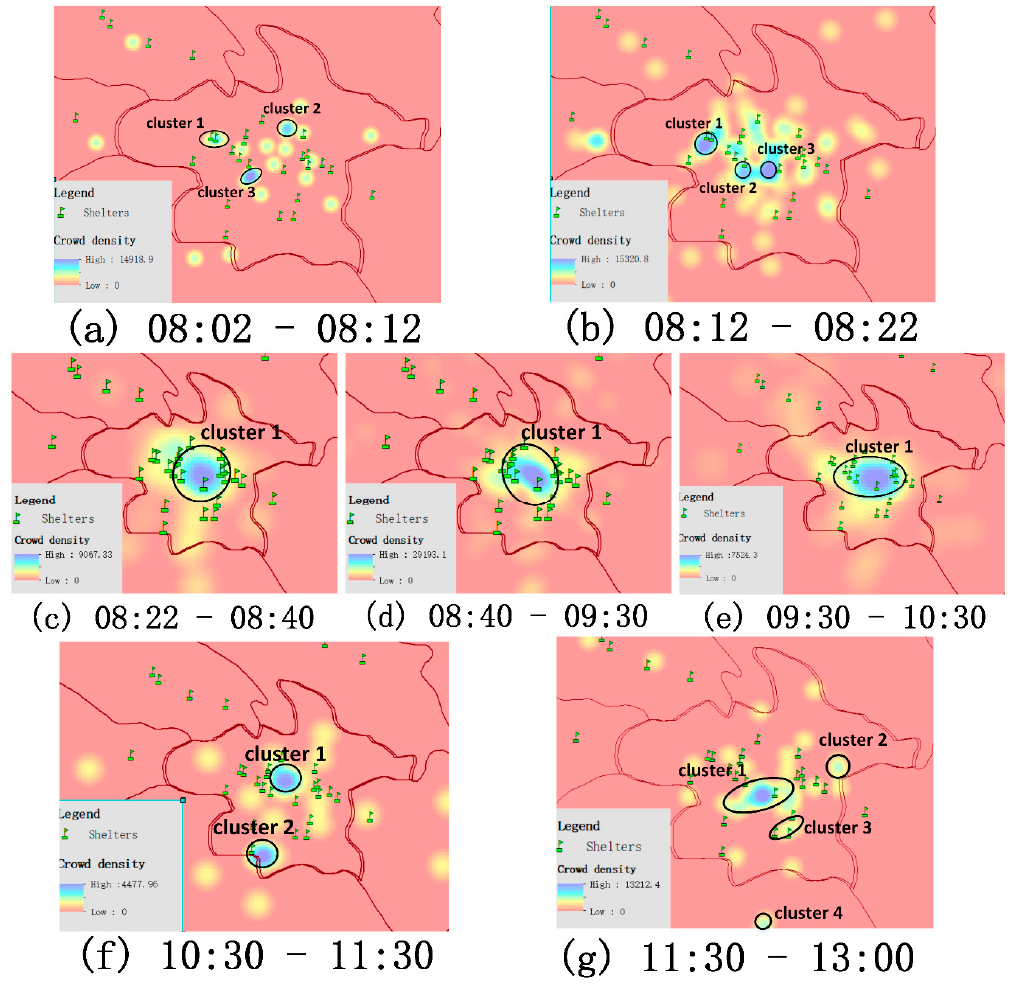
Figure 8. The change characteristics of public spatio-temporal trajectory. This sequence diagram describes how the crowd moved in different small time periods after the earthquake. Among them, the figure ( a ) shows the trajectories of public change in 10 minutes after the earthquake. Three clusters were formed in this period. The figure ( b ) shows the location relationship between each cluster and shelters in the second ten minutes. The figure ( c ), ( d ) and ( e ) shows that all small clusters formed a large cluster over time and it had the largest population between 08:40 and 09:00 as in figure ( d ). The figure ( f ) and ( g ) shows crowd was gradually dissipating and leaving the shelter. From the whole process of analysis, we determined that: (1) When the earthquake happened, people rushed to